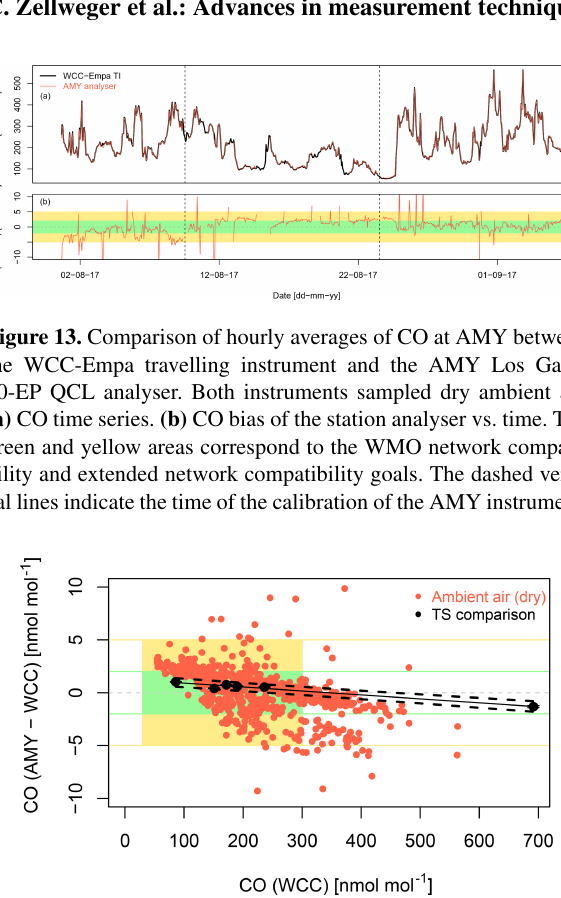
Figure 14. Bias of the AMY Los Gatos 30-EP CO instrument vs. WCC-Empa assigned values. Black dots represent the average of the data at a given level from a specific TS comparison. The error bars show the standard deviation of individual measurement points. The green and yellow lines correspond to the WMO network com- patibility and extended network compatibility goals, and the green and yellow areas to the amount fraction range relevant for PUY. The dashed lines around the regression lines are the Working–Hotelling 95% confidence intervals. The red dots show the bias during the ambient-air